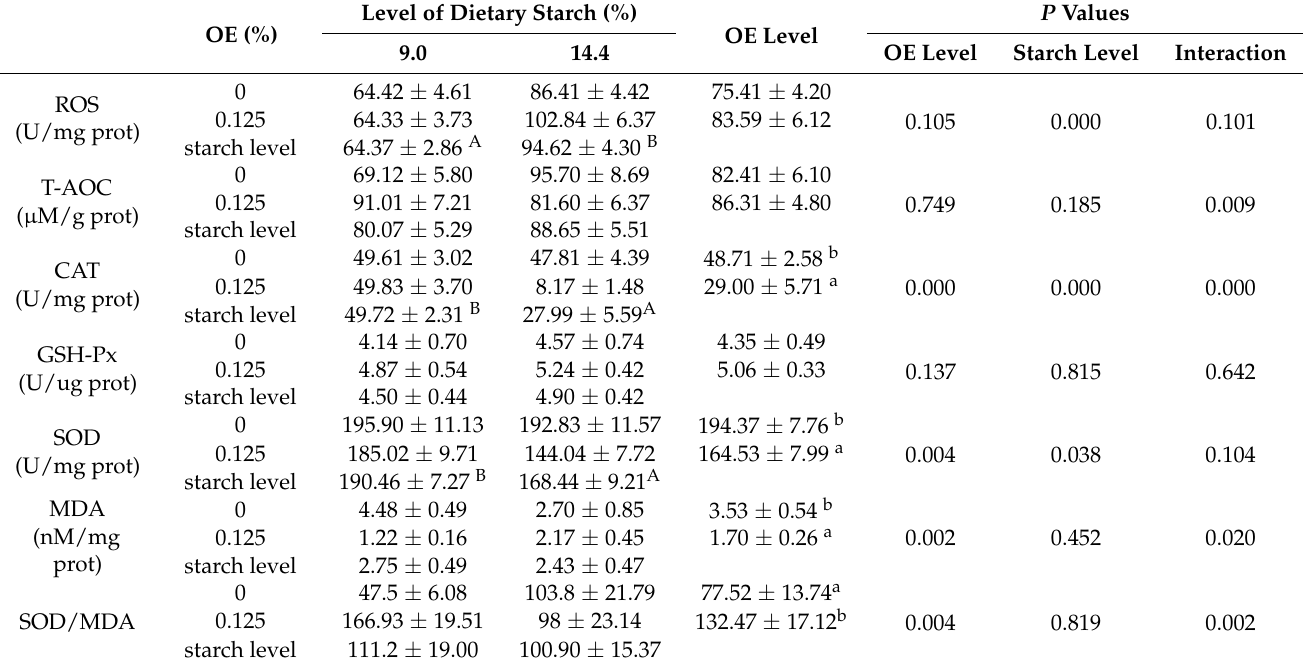
Table 8. Effects of experimental diets on hepatic antioxidant parameters in largemouth